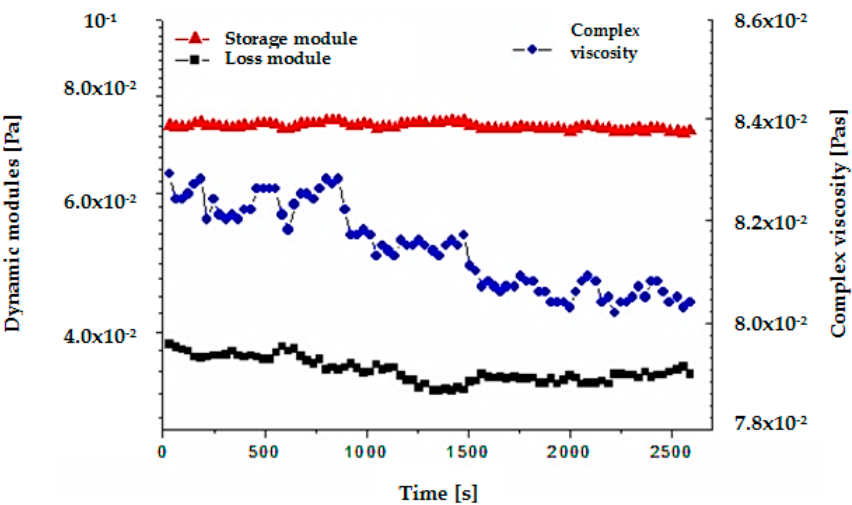
Figure 8. Storage module, loss module and complex viscosity for EM 1b after a relaxation period of 10 min.